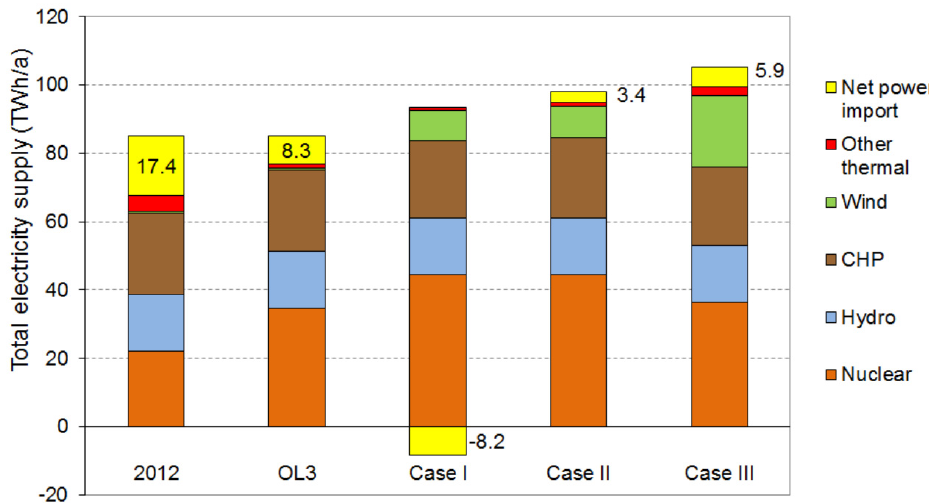
Figure 8. Finland’s power production mix and the share of power exchange in different Cases, compared to 2012 (see Table 3). Power exchange values are labeled.